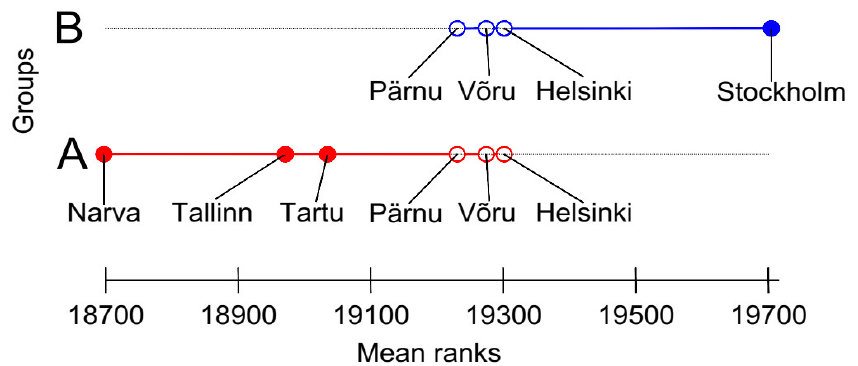
Figure 4. Division of the cities into groups based on the critical difference (Dunn’s test) in average daily surface air temperatures from 2005 to 2019.